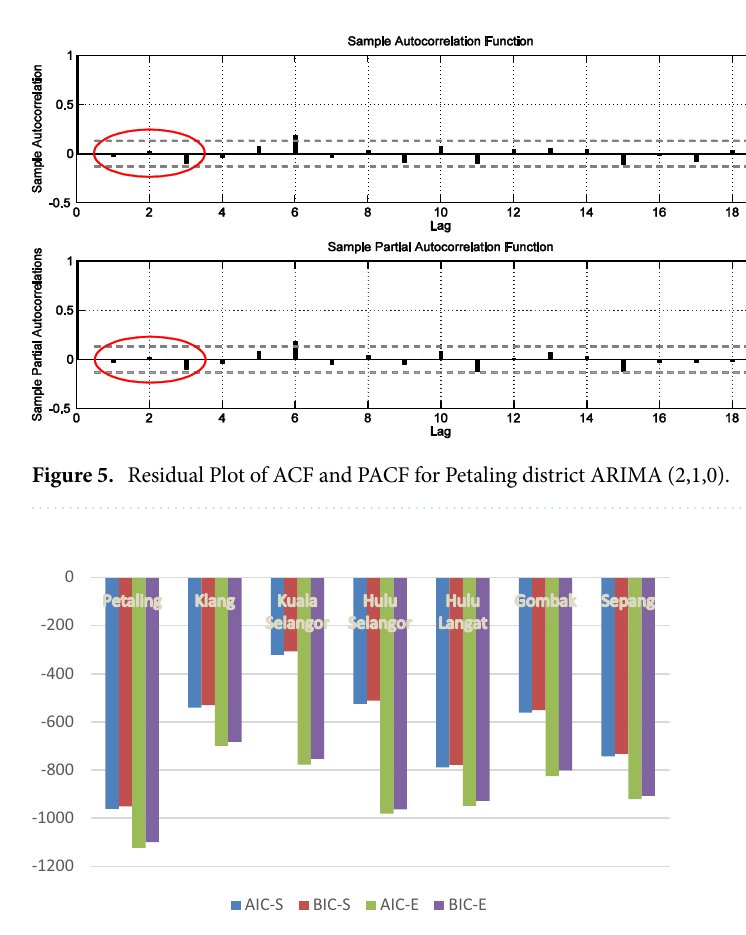
Figure 6. Comparison between ARIMA and ensemble ARIMA